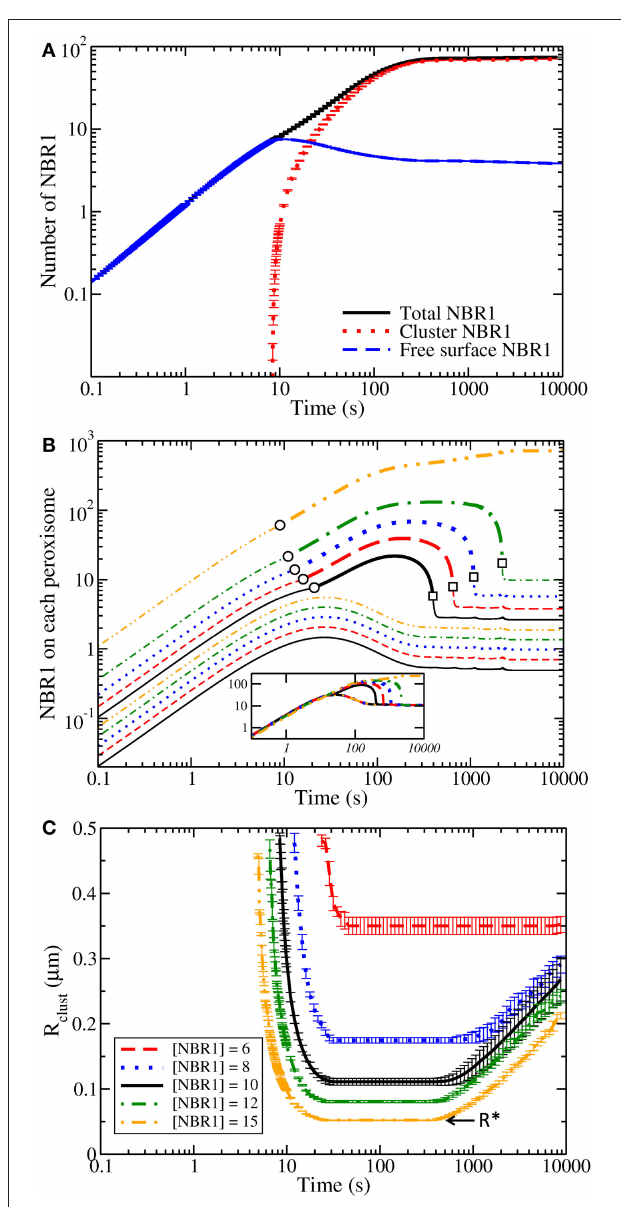
FIGURE 2 | (A) The amount of NBR1 associated with a peroxisome of radius R 0.25 µ m vs. time. The initial ( t 0) bulk concentration is [NBR1] = = = 10 µ m − 3 , with no surface NBR1. At approximately time t 10 s, a cluster is = nucleated and grows thereafter. Cluster growth (dotted red line) allows the total NBR1 (solid black line) to greatly exceed the saturation level exhibited by the free NBR1 (dashed blue line). (B) The total amount of NBR1 vs. time is shown for each of 10 peroxisomes, with radii exponentially distributed between R 0.05 µ m and R 0.50 µ m. The largest peroxisomes have the most = = NBR1, and the smallest the least NBR1. For each peroxisome cluster nucleation is indicated by a circle, evaporation by a square, and a thicker line indicates when a cluster is present. Only the largest five peroxisomes form clusters, starting around t 20 s. For all but the largest peroxisome, the = clusters nucleate, grow, and then shrink again as the clusters coarsen [20]. Inset of (B) shows the NBR1 surface concentration on peroxisomes vs. time—the concentrations for the different peroxisomes, all of different radii, are equal except when a cluster is present. (C) The size of the smallest